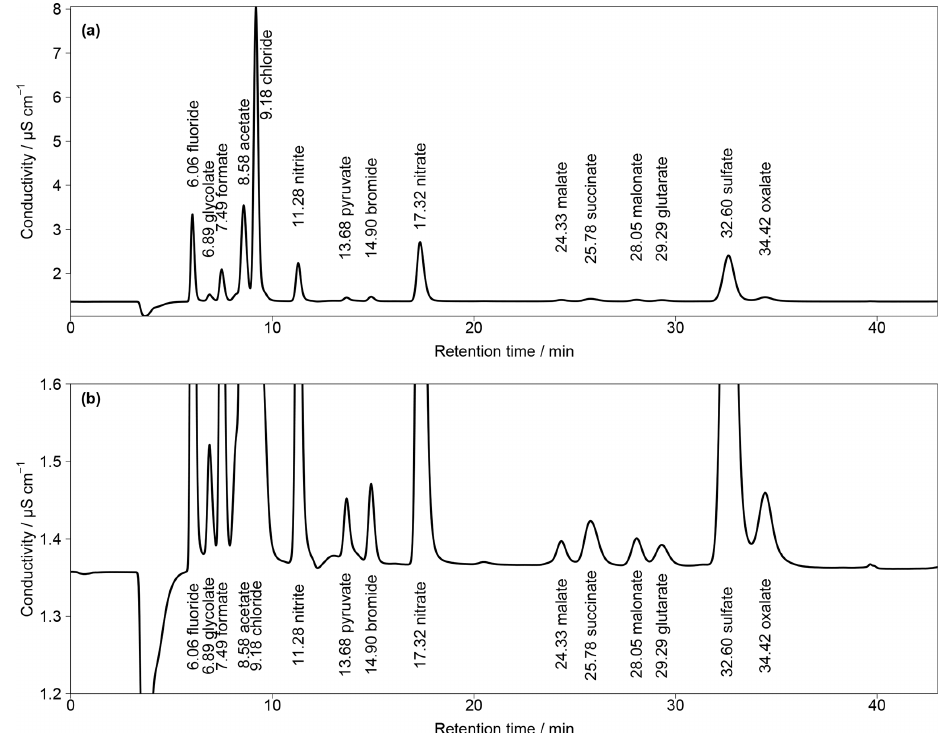
Figure 2. (a) First chromatogram of a standard solution with aqueous concentrations of 10µgL − 1 for Cl − , NO − NO − ; and 1µgL − 1 for F − , Br − and all organic acids. Numbers in front of the ion names are the retention times. T = 65 ◦ C and eluent flow 2 is 0.8mLmin − 1 . (b) Zoom in of (a)